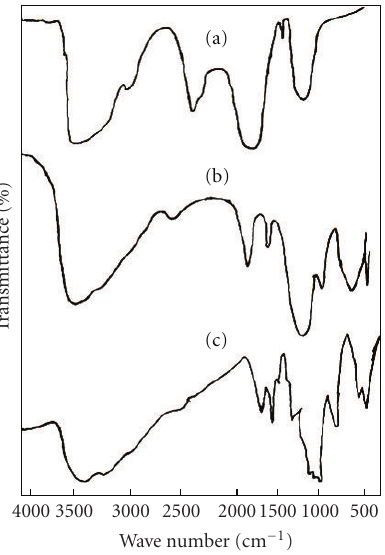
membrane suggests that interstices are negligible, and di ff u- sion across the membrane would occur mainly through the exchanger sites.